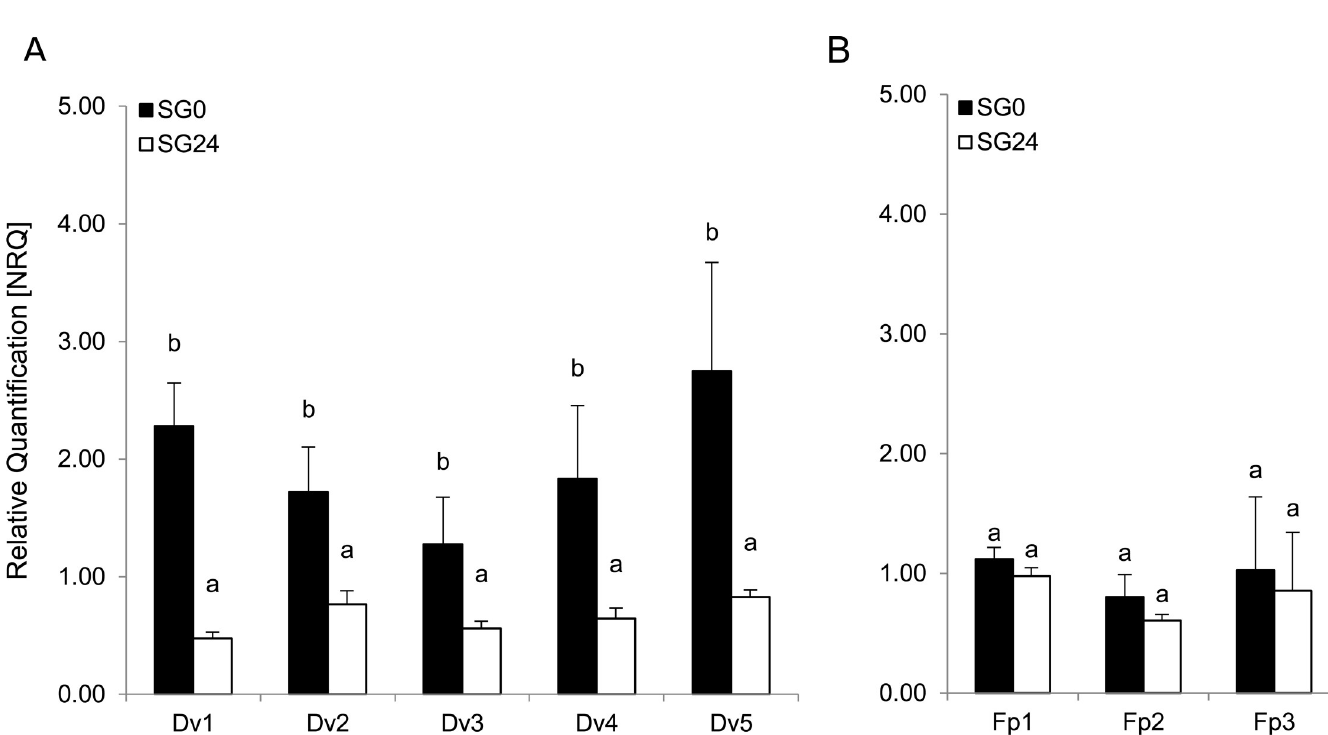
Fig 3. Relative gene expression levels of D . vitifoliae effector genes. Expression levels [NRQ] of genes coding for A) conserved effectors of D . vitifoliae and A . pisum (Dv1-5) and B) false positives detected within the salivary gland proteome of D . vitifoliae but not associated to feeding (Fp1-3). RNA was extracted from salivary glands dissected from of feeding (SG0) and starving larvae (SG24). ActinA1 (DV3000100) was used as reference gene. Error bars indicate standard deviations of three independent biological replicates each consisting of salivary glands dissected from 100 individuals. Minor letters refer to significant differences obtained by Independent T-tests (p <